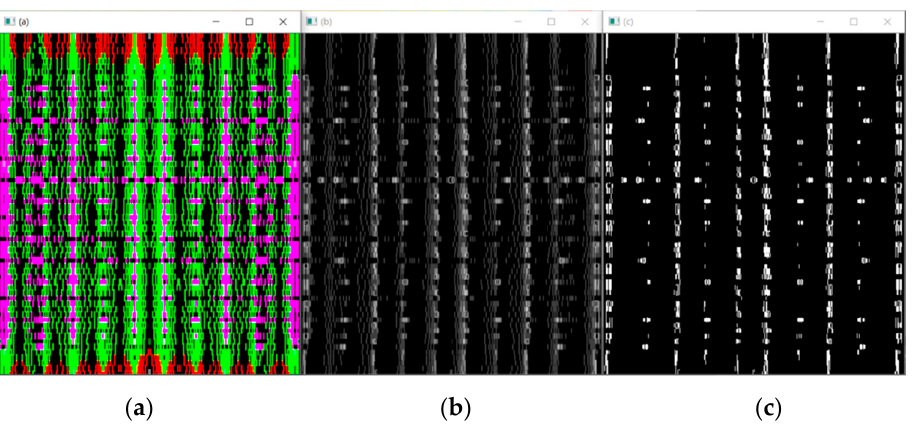
Figure 10. Extraction of the edge information of the ROI. ( a ) Edge detection result; ( b ) grayscale image; ( c ) binarized image.